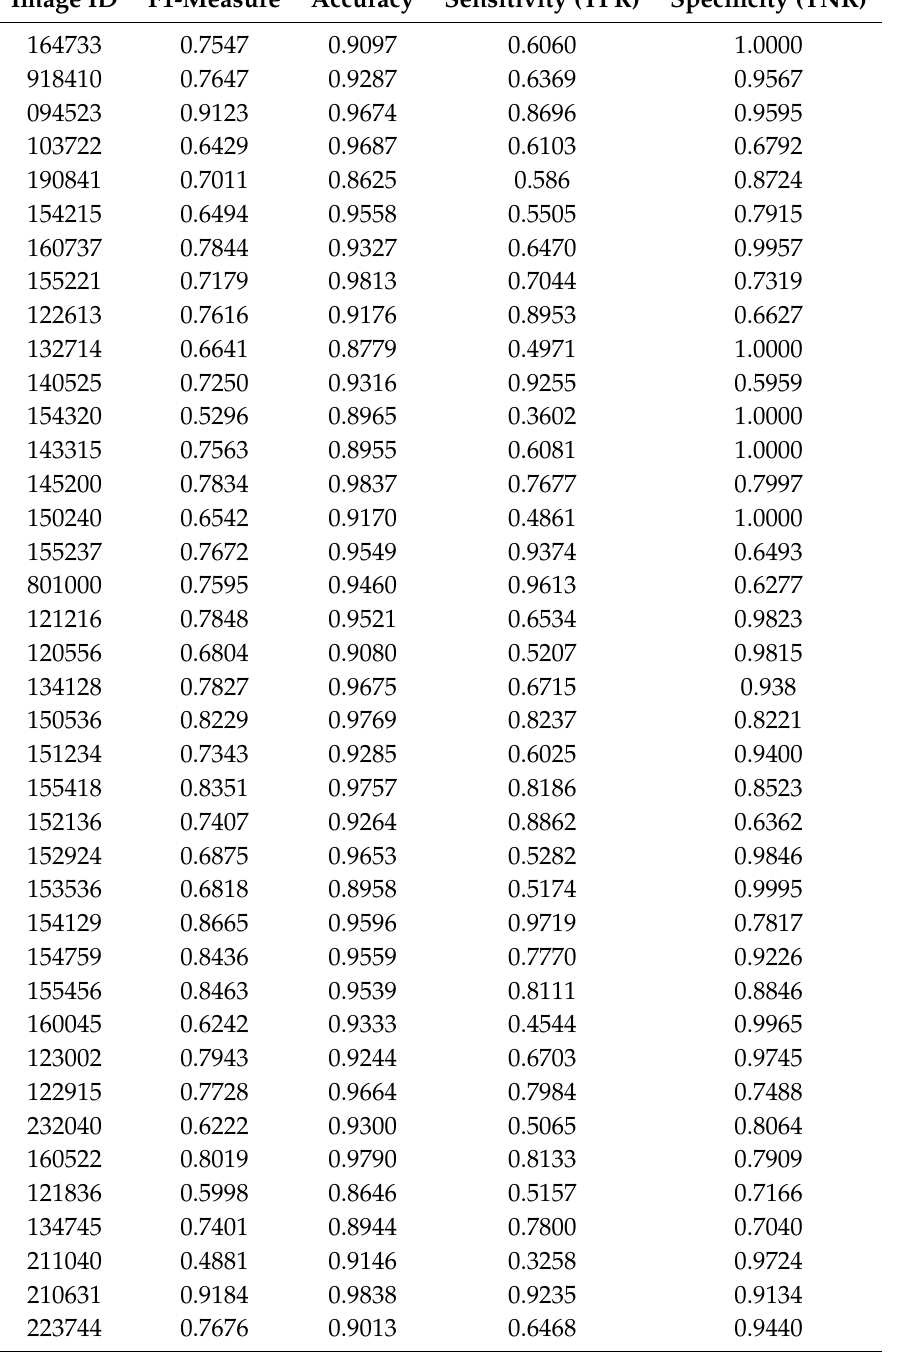
Table A1. Results computed from the confusion matrices of the comparison between manually and automatically segmented images of the conjunctiva for the entire dataset of 94